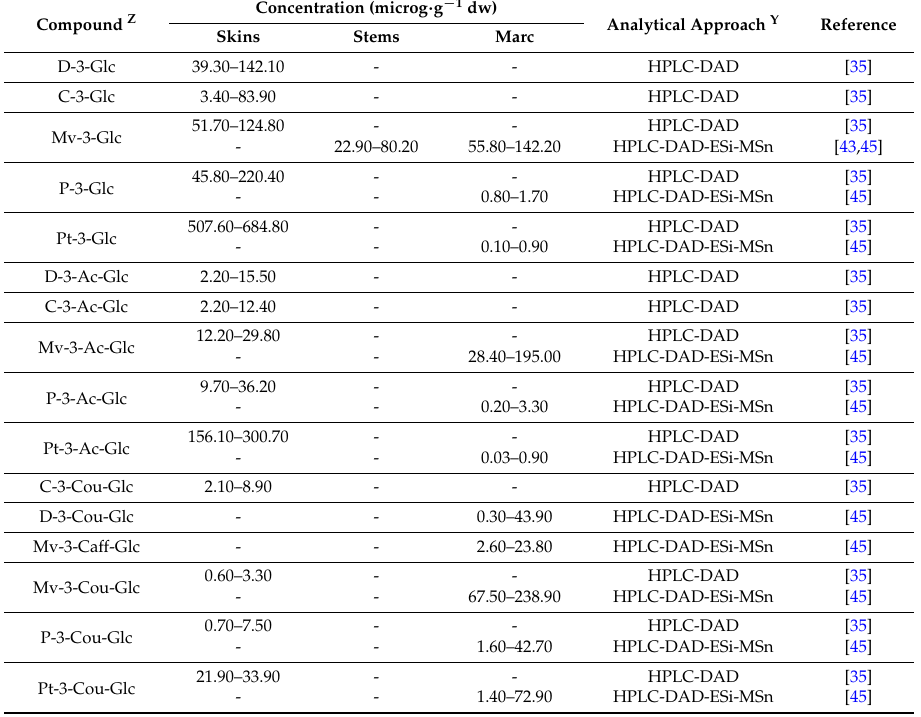
Table 4. Anthocyanidins present in winery